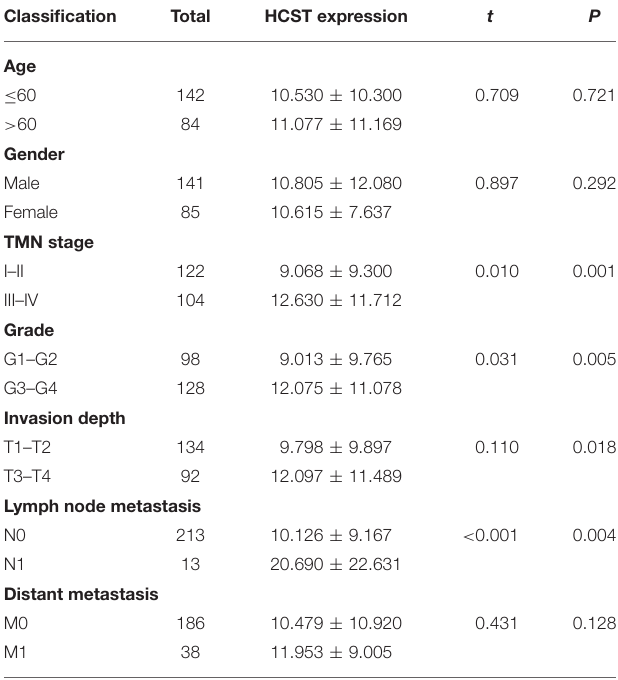
TABLE 1 | Relationship between HCST expression level and clinicopathological variables in ccRCC patients.